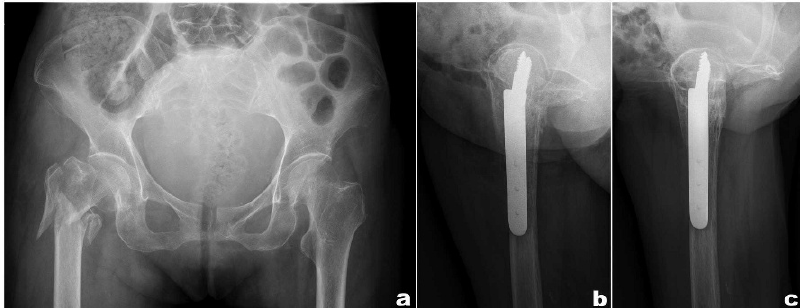
Figure 4 - A 72-year-old female patient with a type 31-A3.3 fracture. A) Initial radiograph. B) Lateral radiograph of the proximal femur at the 6th postoperative week. C) Lateral radiograph of the proximal femur at the 12th postoperative month showing the head penetration of the proximal neck